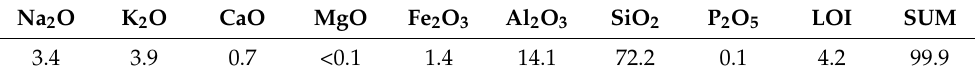
Table 2. Chemical composition of the perlite raw material used for zeolite